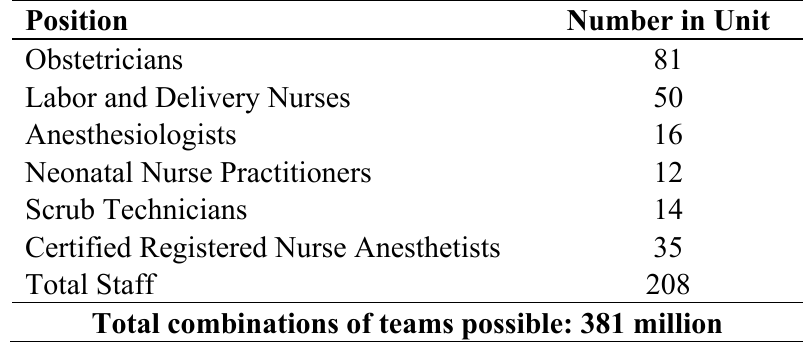
Table 3. Example of rapidly-formed team possibilities for an obstetrics